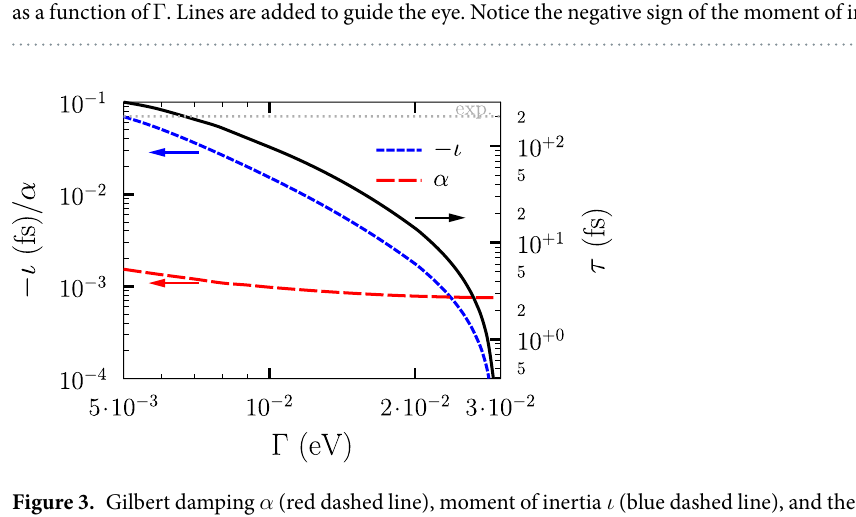
Figure 3. Gilbert damping α (red dashed line), moment of inertia ι (blue dashed line), and the resulting electron (Bloch-state) lifetime τ = − ι / α (black line) as a function of Γ in the intra-band region for Fe bulk. Arrows indicate the ordinate axis. The grey dotted line shows the experimental value from ref. 31. Notice the negative sign of the moment of